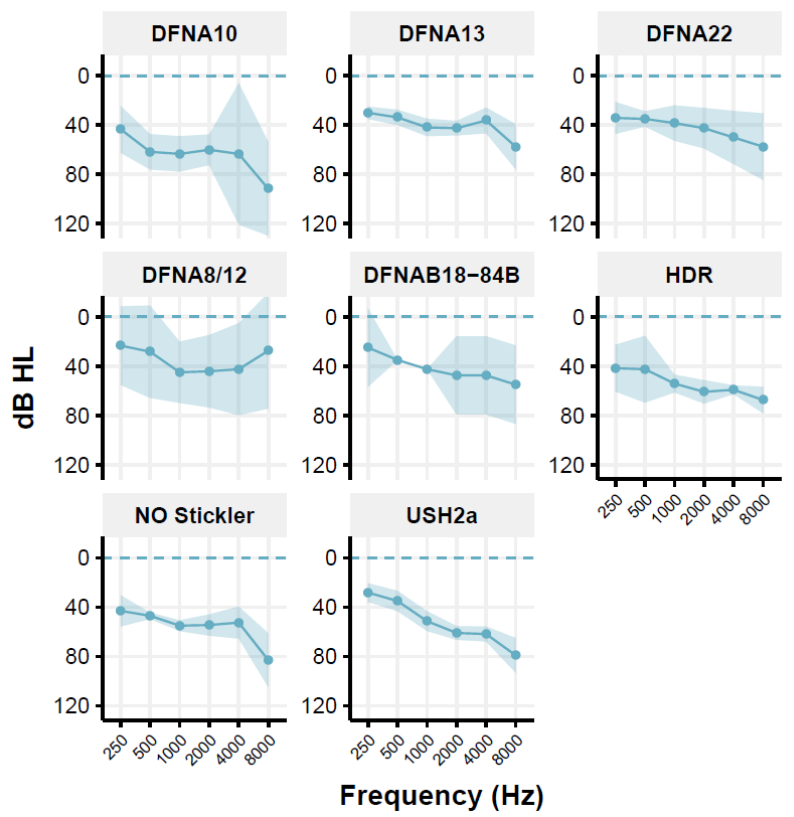
Figure 1. Mean audiogram of the patient groups showing the mean threshold for the frequencies tested (right and left ear averaged), as well as the 95% confidence interval around the mean.